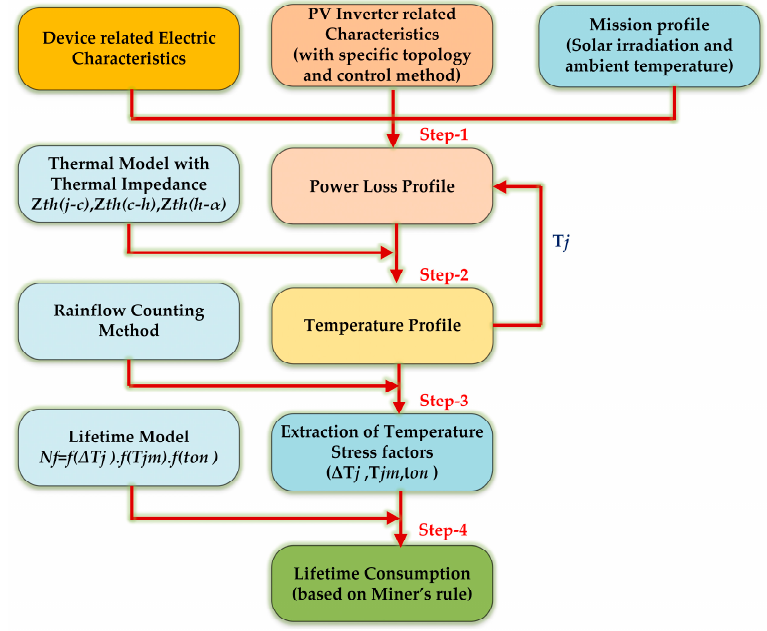
Figure 32. Lifetime evaluation procedure of the power devices in the PV inverter.